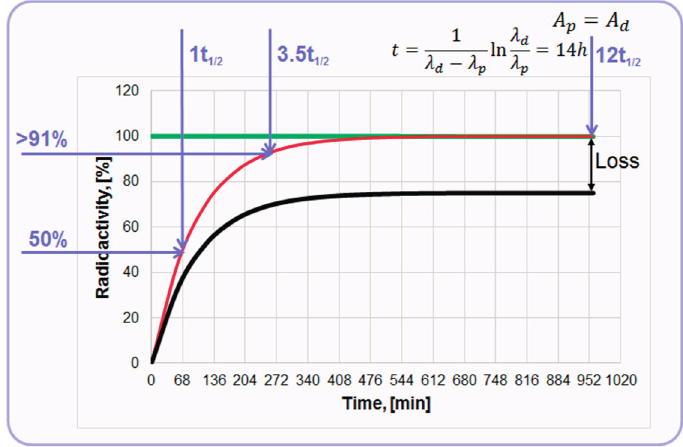
Figure 3. Graph of the secular equilibrium with 68 Ge decay and 68 Ga accumulation. The green line represents decay of 68 Ge described by (cid:1827) represents ingrowth of 68 Ga described by (cid:1827) (cid:3031) (cid:4666)(cid:1872)(cid:4667) (cid:3404) the black line represents accumulation kinetics of 68 Ga with correction for hypothetical elution